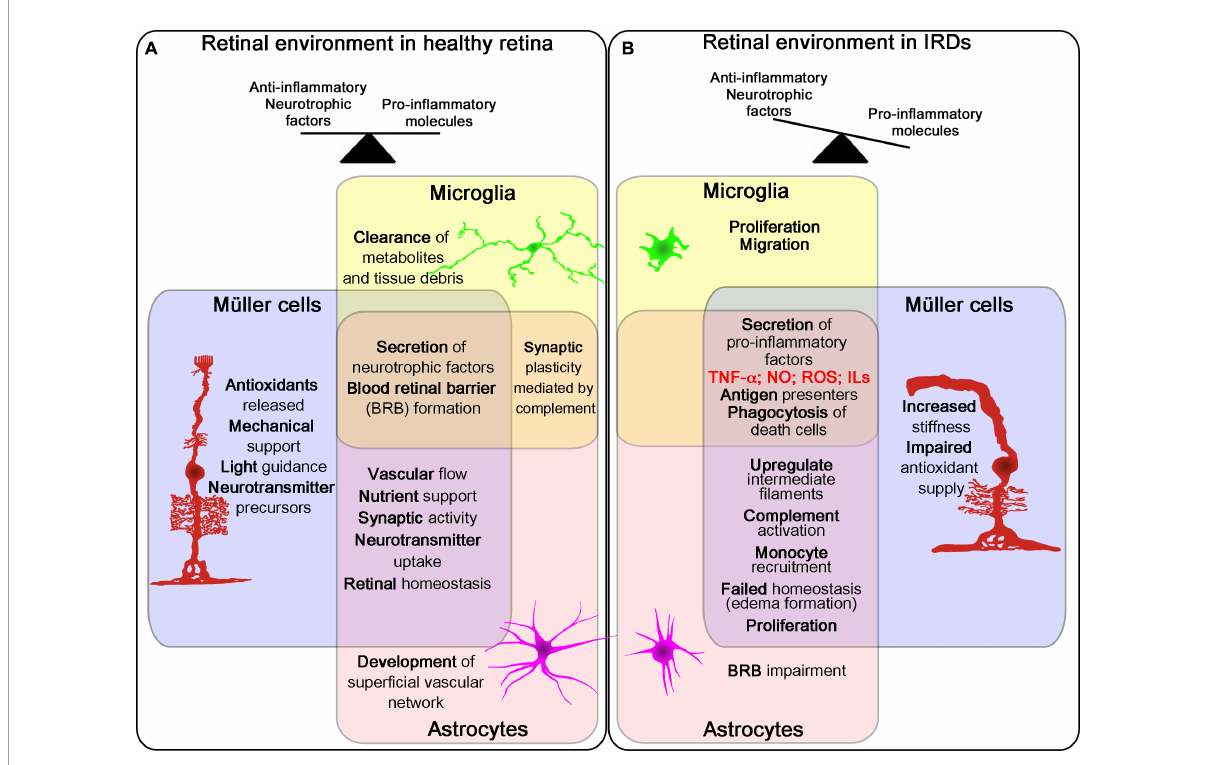
FIGURE2 Role of retina glial cells in IRDs. Schematic representation of the three glial cell types in the retina (Müller cells, microglia and astrocytes) and their main functions and changes in healthy and disease retina. The three cells work together in different processes affecting retinal homeostasis in healthy retina (A) . During the course of retinal degeneration, these cells secrete pro-inflammatory factors and promote proliferation, migration and phagocytosis, increasing inflammatory signals in the tissue (B)